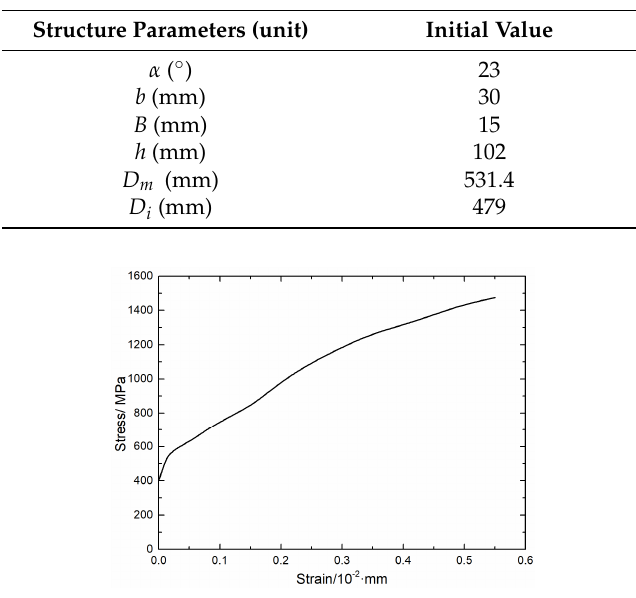
Figure 6. The stress–strain curve of the VX gasket material.